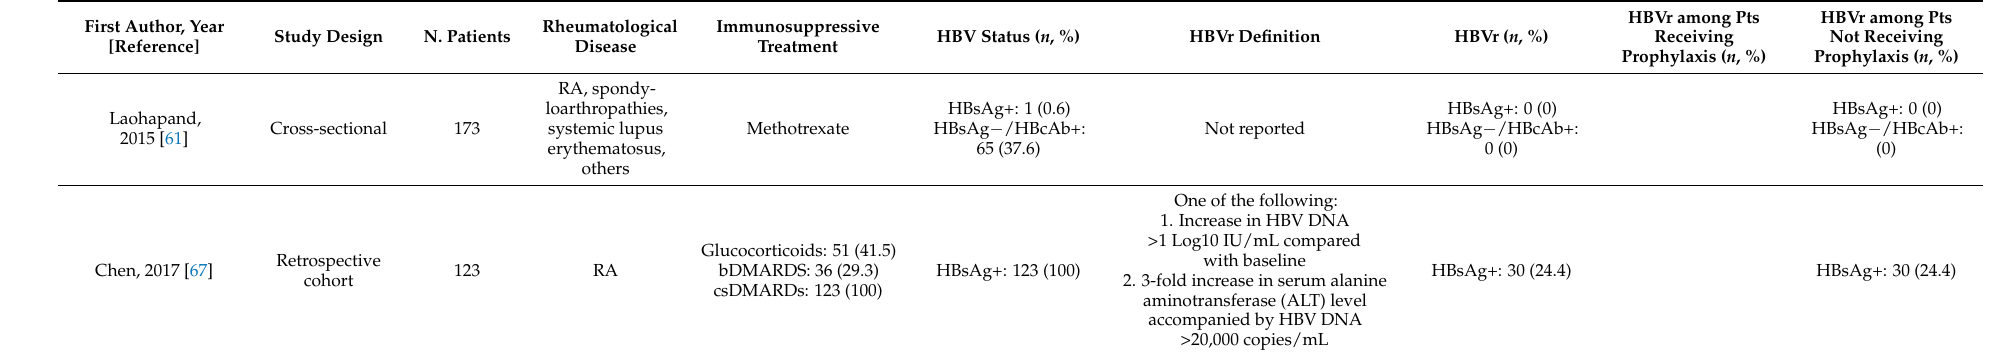
Table 3. Studies on HBV reactivation in patients with rheumatological